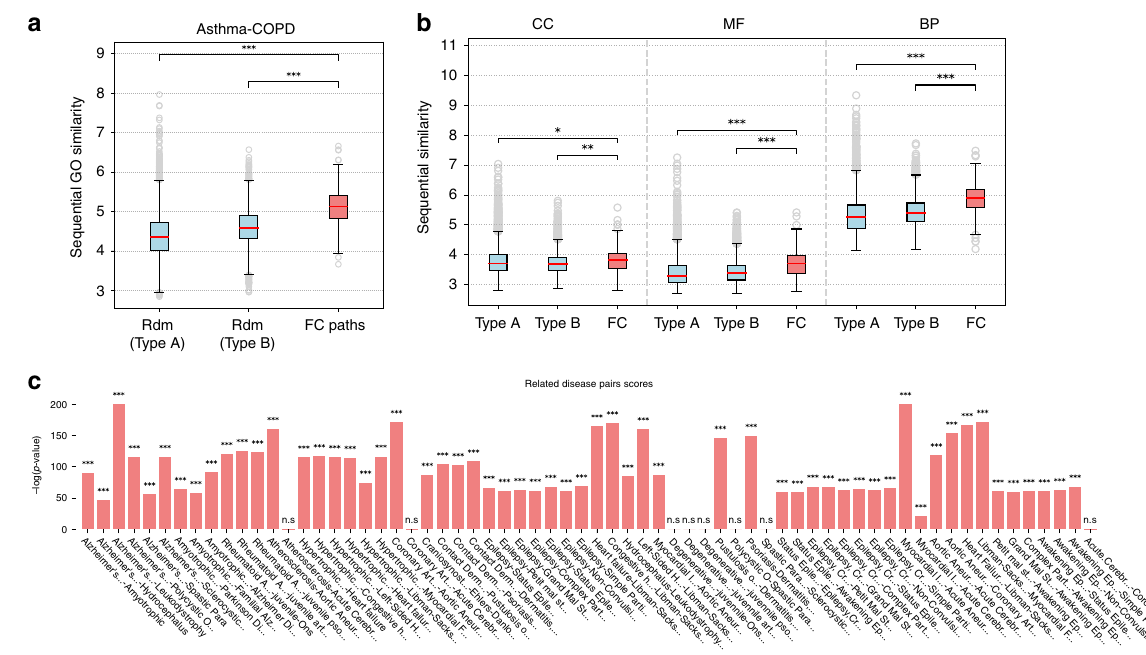
Fig. 2 GO similarity of fl ow central paths. a Distribution of sequential GO similarities (SS) of random paths of Type A, Type B, and FC paths; b SS of Type A, Type B, and FC paths calculated for the three main GO root terms: cellular component (CC), molecular function (MF), and biological process (BP). c Worst-case p -values of comparison between FC paths and random paths for each related disease pair. In the boxplots, boxes indicate the quartiles, whiskers extend to an additional 1.5 * IQR interval, and the medians are highlighted in red. One, two, and three asterisks, respectively, denote a Mann – Whitney p -value that is <0.05, 1e − 4, and 1e − 10, and “ n.s. ” stands for a non-signi fi cant